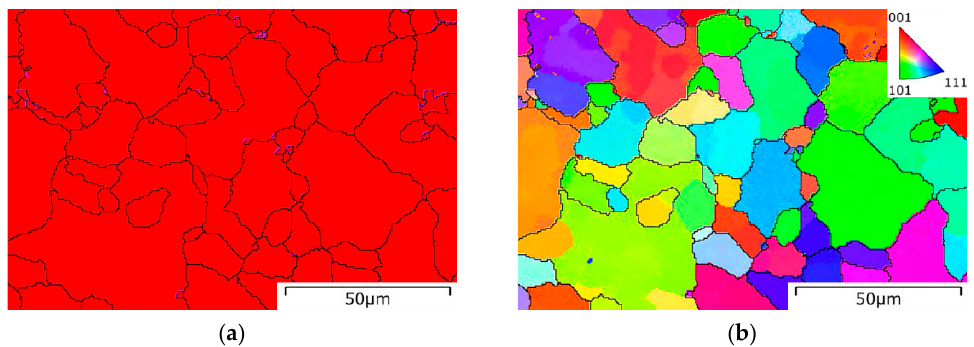
Figure 11. ( a ) EBSD map of BCC (red) phases and ( b ) combined inverse pole figure (IPF) orientation map of the BCC matric phase and particles. An IPF color-coding map is shown as an insert in ( b ). The maps were taken from the surface area of Re 0.3 TaTiZr shown in Figure 10b. Grain boundaries with misorientations >10° are shown as dark lines.